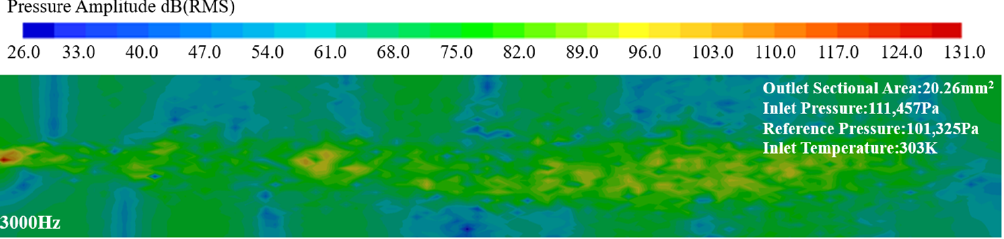
Figure 23. Cloud map of the 3000 Hz near-field sound pressure levels of the standard